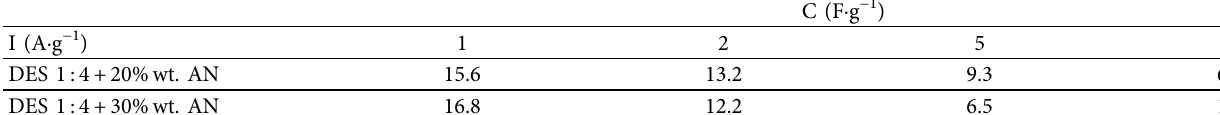
Figure 8: The enlarged working voltage of ESs using various DES-based electrolytes ( v � 10mV · s − 1 ). The scan was repeated 100 times for each operating voltage. Table 6: Capacitance was calculated from GCPL cycling test at various scan